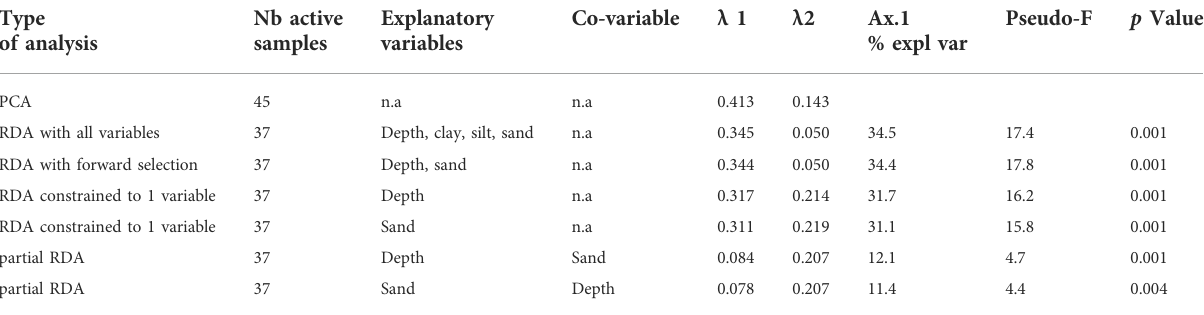
TABLE 2 Summary statistics for the multivariate analyses (PCA, RDAs, partial RDAs) performed on the Kalakuli surface sediment diatom dataset. Signi fi cance tests were performed with 999 Monte Carlo